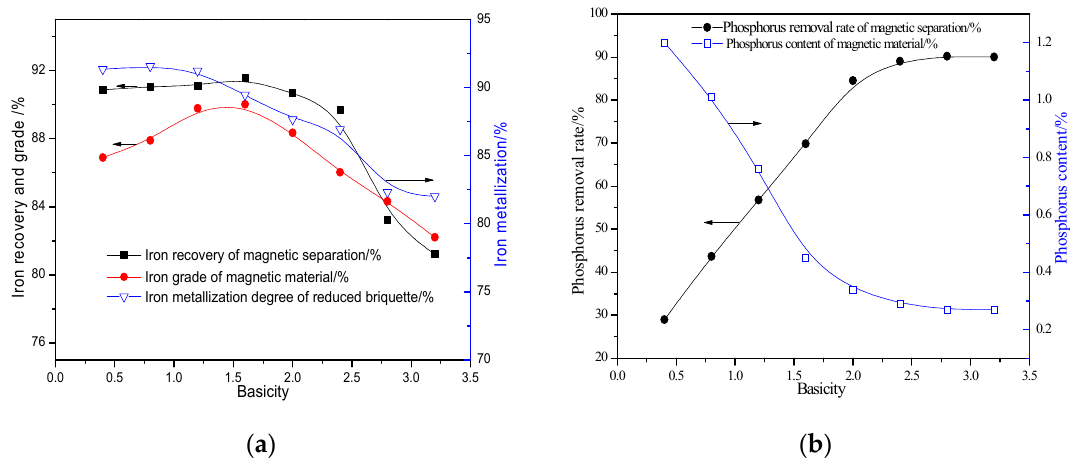
Figure 8. Effects of basicity on beneficiation of iron and phosphorus removal (ore blended with 10% sodium sulfate and reducing at 1350 °C for 10 min with C/Fe = 0.48). ( a ) Effect of basicity on iron recovery; ( b ) effect of basicity on phosphorus removal.